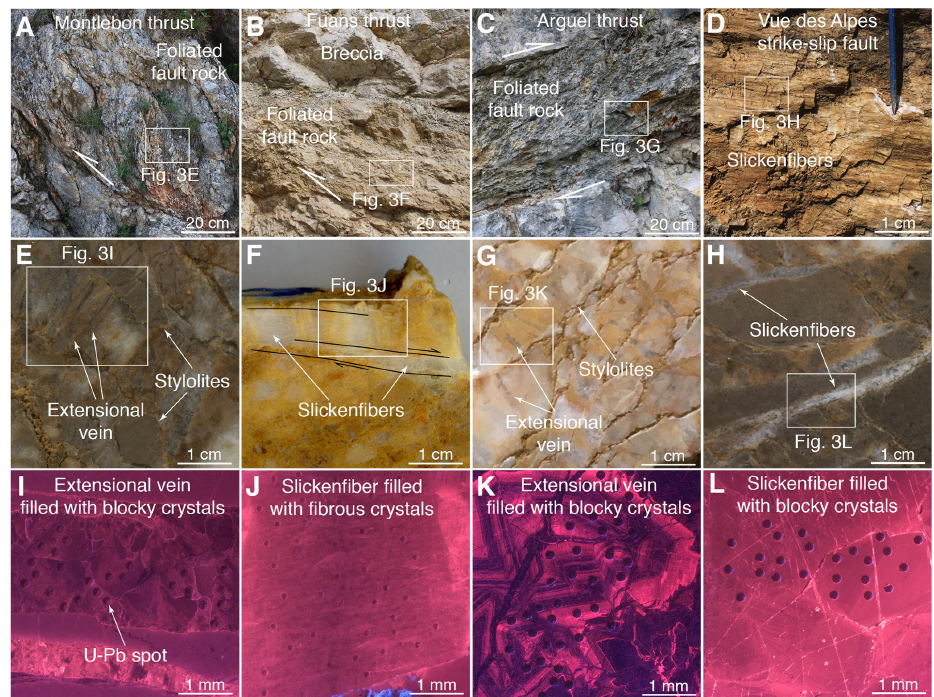
Figure 3. Foliated fault rocks in the fault core of the Montlebon thrust (a) , Arguel thrust (b) , and (c) Fuans thrust. (d) Detail of minor fault plane along the Vue des Alpes strike-slip fault showing calcite slickenfibres. (e) Hand sample from the Montlebon thrust showing host rock sigmoids bounded by stylolites and extensional veins perpendicular to stylolites. (f) Hand sample from the Fuans thrust showing host rock sigmoids bounded by stylolites and extensional veins perpendicular to stylolites. (g) Hand sample from the Arguel thrust showing extensional veins with crackle-like texture. (h) Hand sample from a minor fault plane along the Vue des Alpes strike-slip fault showing slickenfibres developed along dissolution planes. (i–l) Cathodoluminescence microphotographs of thin sections showing extensional veins and slickenfibres from the studied faults with ablation craters of the U–Pb